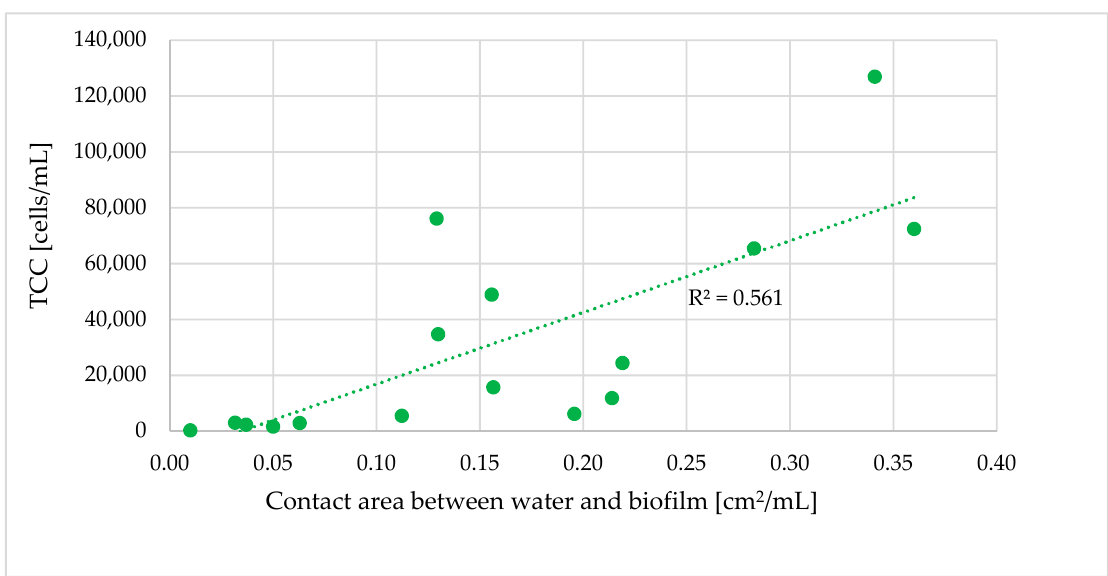
Figure 5. Correlation between the contact area for biofilm and water, and TCC.